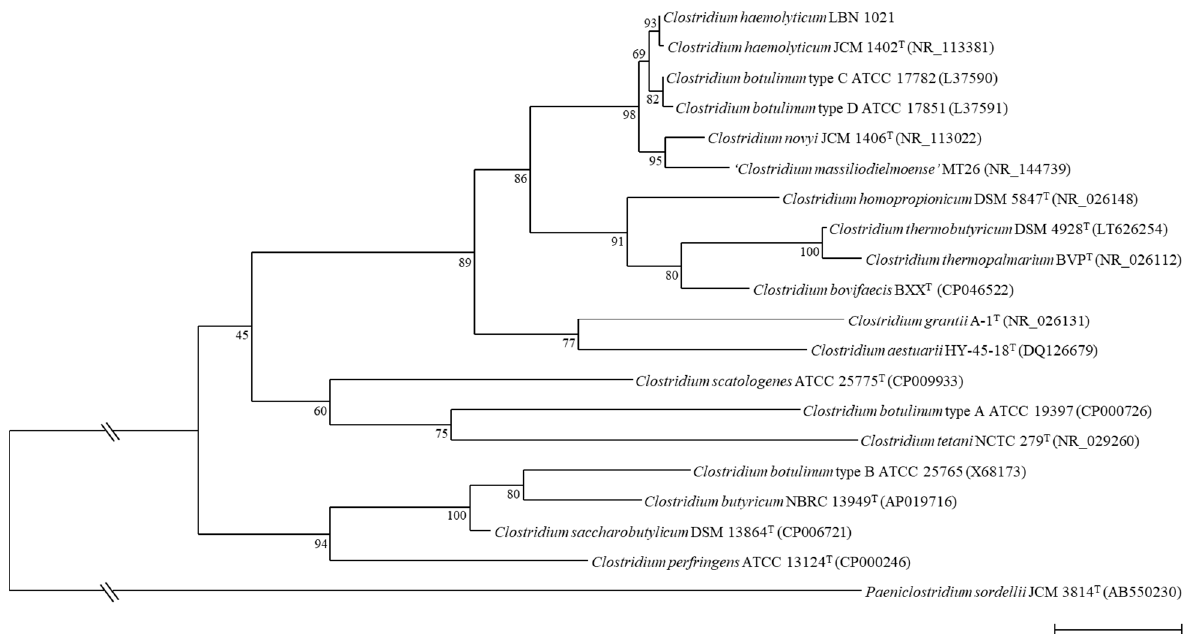
Figure 1. Maximum likelihood (computed by PHYML, model GTR plus gamma distribution and invariant sites) phyloge- netic tree based on partial 16S rRNA gene sequences (1420 nt) showing relationships between the strain isolated in our patient (LBN 1021) and related clostridia species. The Paeniclostridium sordellii 16S rRNA gene sequence (AB550230) was used as the outgroup. Numbers at nodes indicate percentages of bootstrap support, based on analysis of 100 replicates. Species represented in single quotes are effectively published but not validly published. Bar, 0.02 substitutions per site.